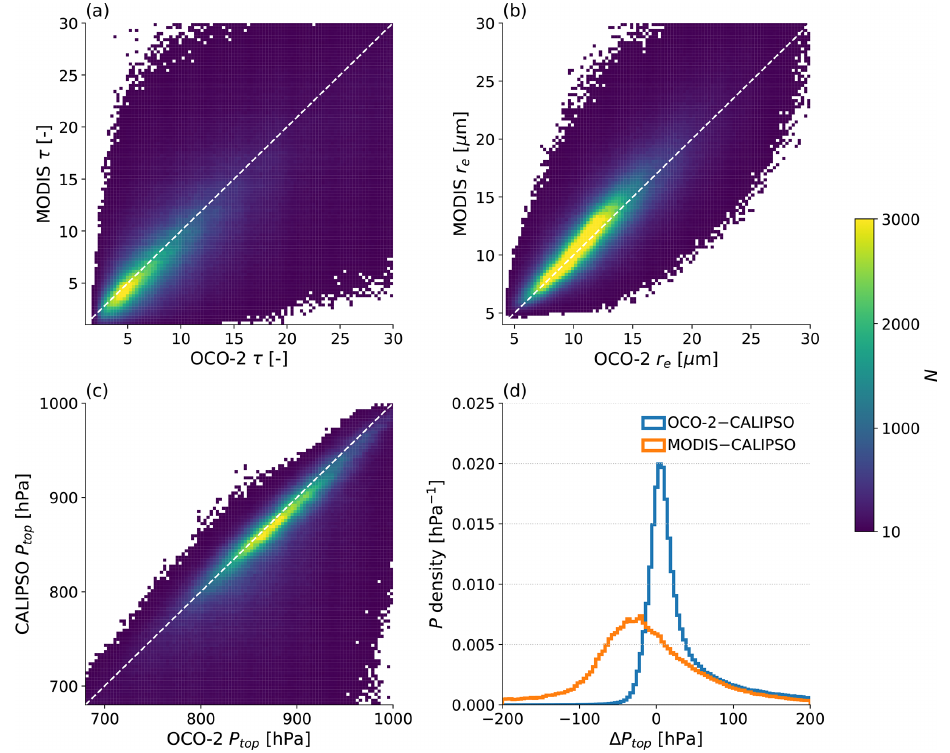
Figure 5. Inter-satellite comparison of retrieved cloud properties of (a) MODIS vs. OCO-2 τ , (b) MODIS vs. OCO-2 r e , (c) CALIPSO vs. OCO-2 P top , and (d) OCO-2 or MODIS P top minus CALIPSO P top . The colour bar on the right applies to (a, b, c)